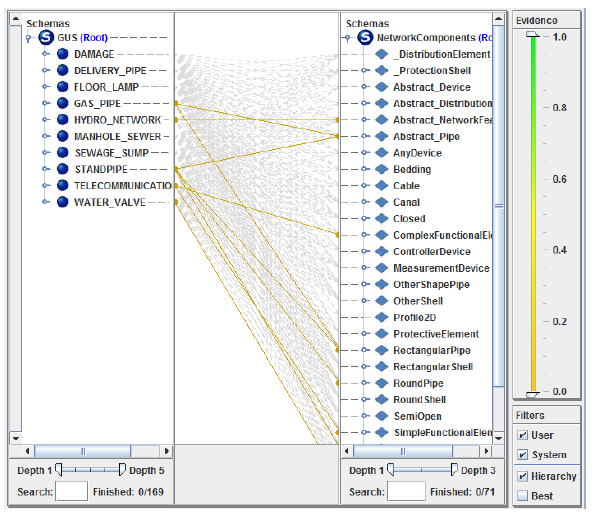
Figure 3. Example of the Harmony interface of